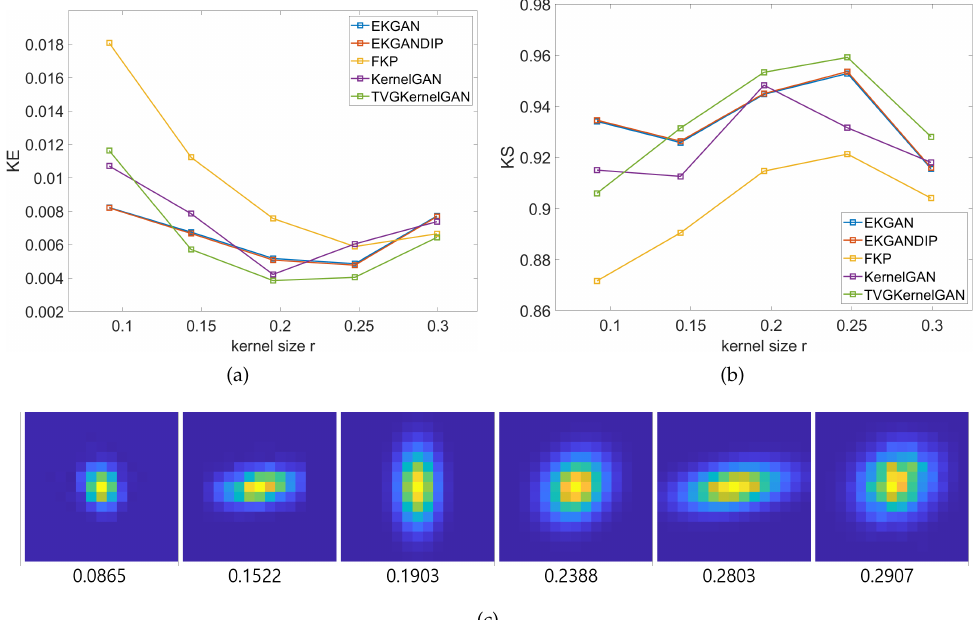
Figure 8. KE and KS curves according to the kernel sizes r . ( a ) KE, ( b ) KS, ( c ) the kernel examples and the corresponding kernel sizes r . Table 1. Comparison of the kernel estimation results in terms of quantitative score, kernel error (KE) and kernel similarity